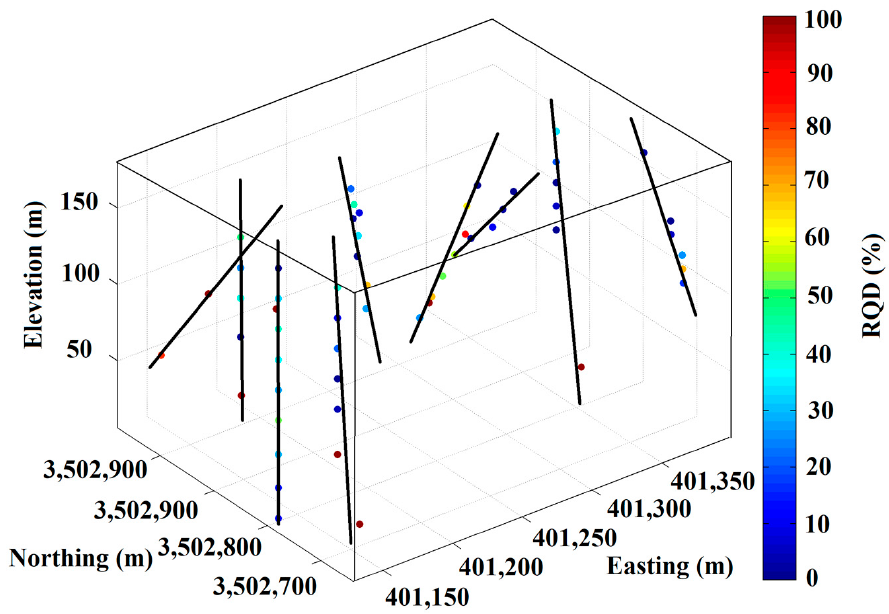
Figure 4. 3D location map 9 boreholes drilled in the study area; complexity in the ore deposit imposed inclined boreholes to capture the potential phosphorus in the area.